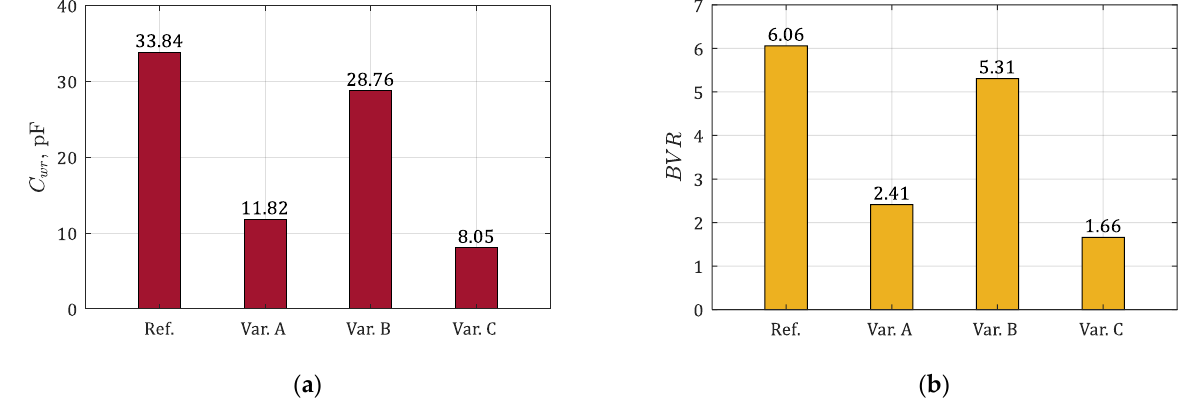
Figure 17. Comparison of capacitances C wr ( a ) and BVR coefficients ( b ) for selected solution vari-